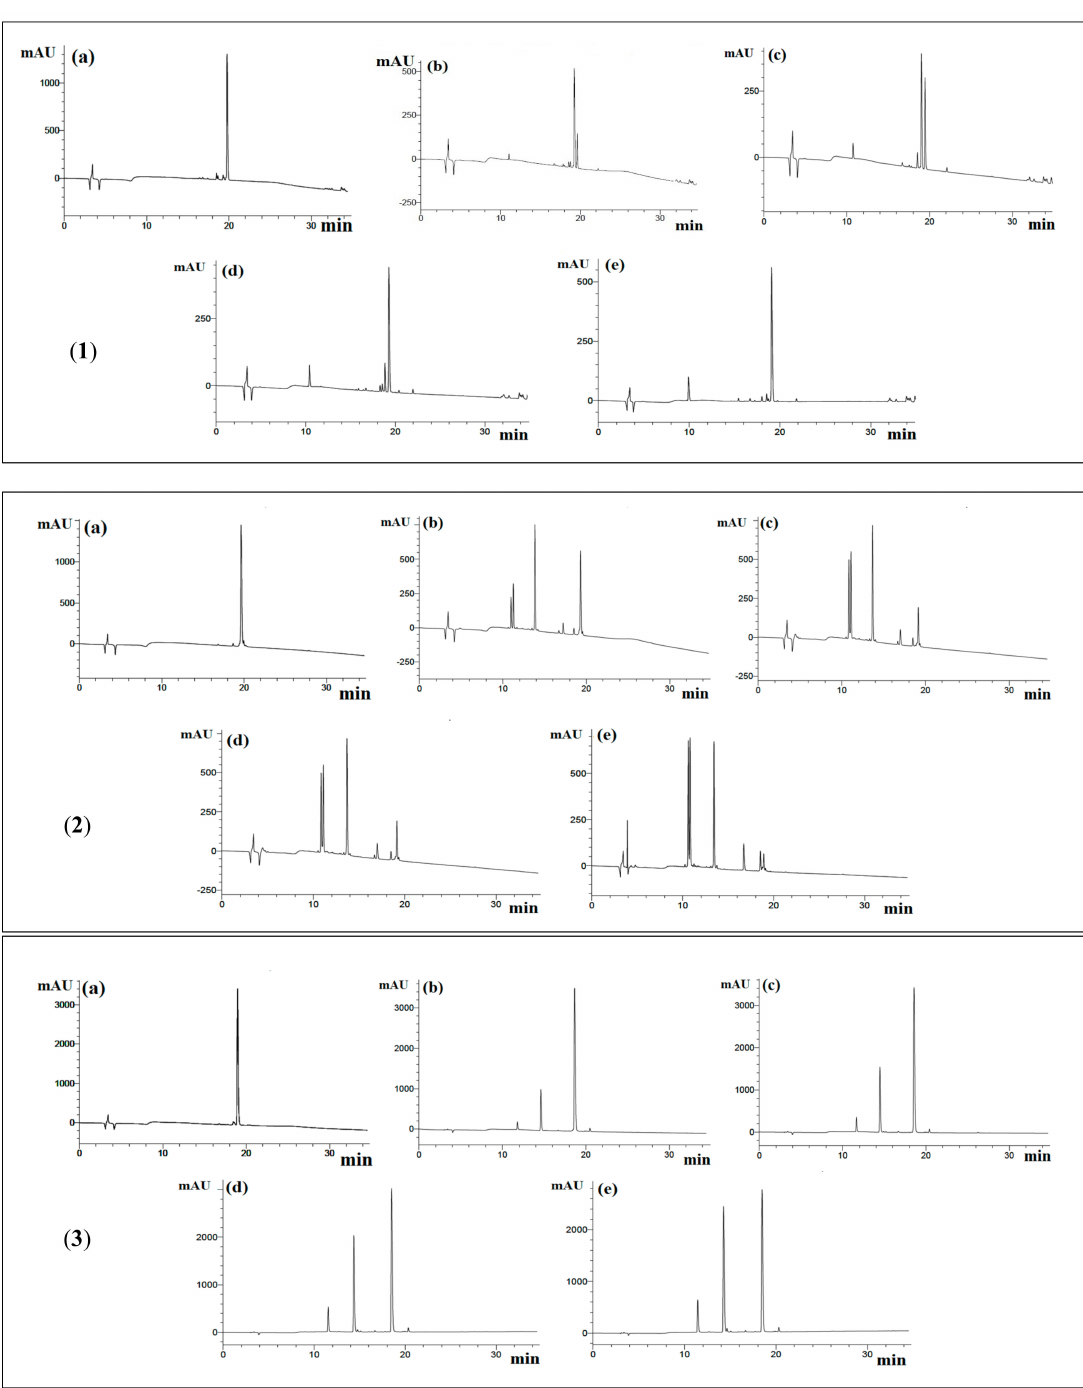
Figure 1. Reversed-phase high performance liquid chromatography (RP-HPLC) chromatograms of hydrolysis of peptides by ACE. ( 1 ) YLLLK; ( 2 ) WAFS ( 3 ) GVQEGAGHYALL; ( a ) before incubation; ( b ) 0.5 h of incubation; ( c ) 1 h of incubation; ( d ) 2 h of incubation; ( e ) 3 h of incubation. 20 µ L of sample was eluted by mobile phase A (0.1% of TFA in deionized water) and 0–60% gradient of mobile phase B (0.1% of TFA in CH 3 CN) for 5–35 min on a C18